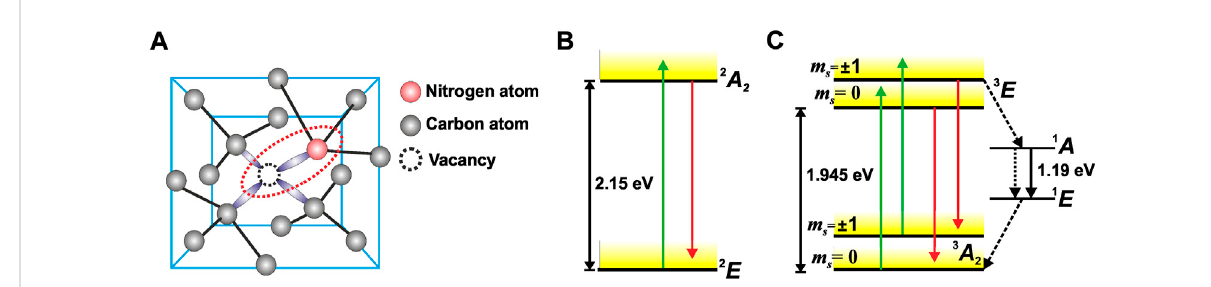
FIGURE 1 (A) The diamond structure containing a carbon vacancy and a substitutional nitrogen atom forming NV center. (B) The energy level diagram of NV 0 center with a ground state ( 2 E ) and an excited state ( 2 A 2 ). (C) The energy level diagram of NV − center with a triplet ground state ( 3 A 2 ), an excited state ( 3 E ), and metastable states ( 1 A and 1 E